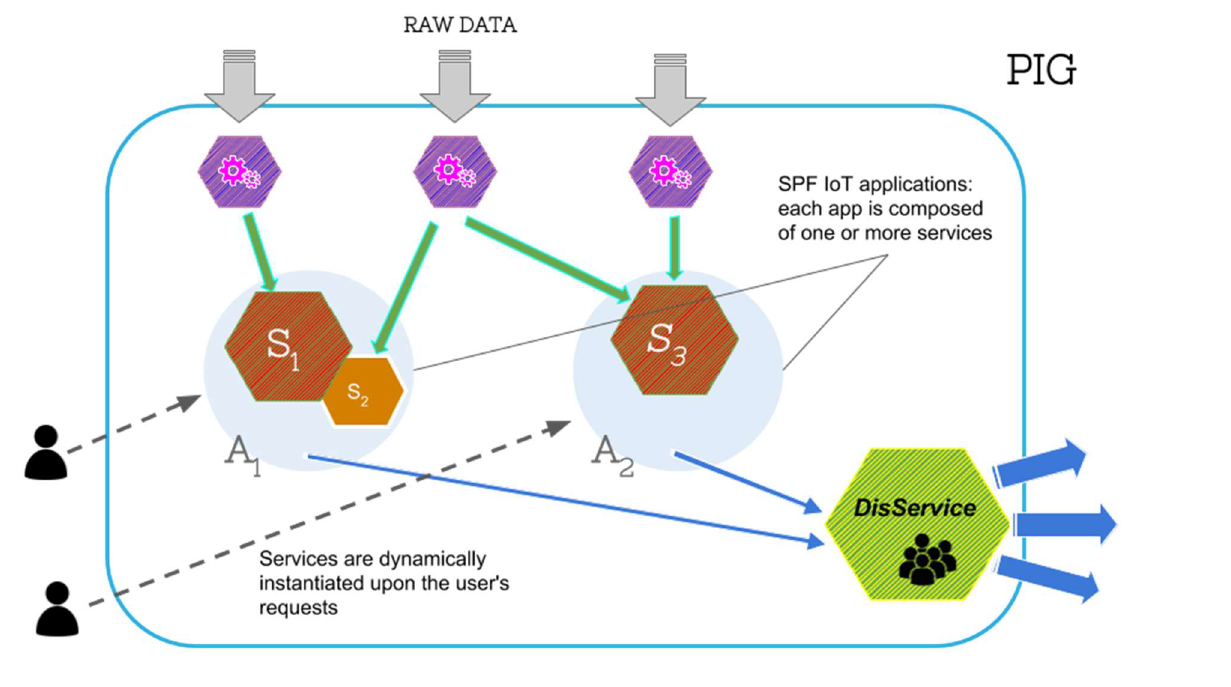
Figure 3 . Information flow in the SPF